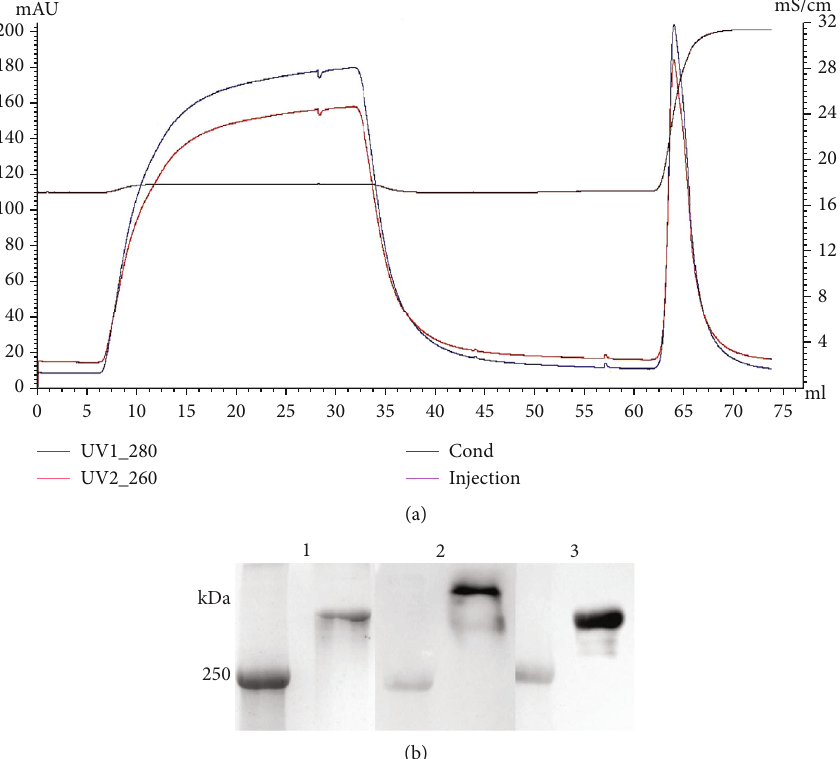
Figure 1: Puri fi cation of Lp(a). (a) Elution pro fi le of Lp(a). A mixture of Lp(a) and LDL was run through a Q FF strong anion exchanger column and eluted with 300mM NaCl, 20 mM Tris, and 1mM EDTA (pH7.4). The second peak corresponds to Lp(a). (b) SDS-PAGE and immunoblot analyses of Lp(a). SDS-PAGE gel stained with Coomassie blue (lane 1); an identical gel subjected to western blotting with either anti-apoB100 Ab (lane 2) or anti-apo(a) Ab (lane